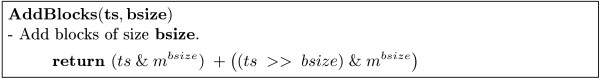
Subroutine AddBlocks. This subroutine takes a 128 bit word ts divided into blocks of size bsize as input and adds every two blocks together into a new block of size 2·bsize.